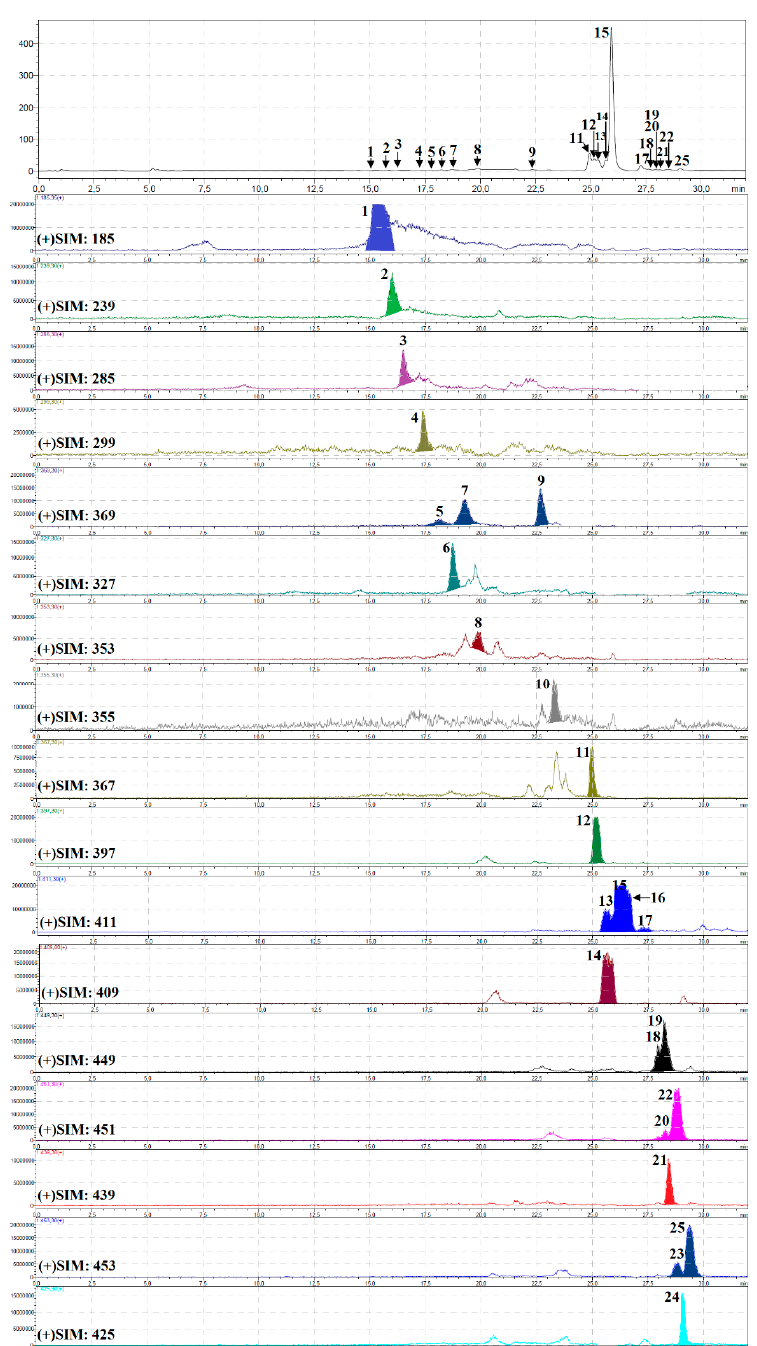
Figure 2. HPLC-DAD chromatogram (330 nm; ( a ) and HPLC-ESI-MS chromatograms (selected ion monitoring mode (SIM), positive ionization; ( b ) of hexane fraction of Phlojodicarpus sibiricus roots. Compounds are numbered as listed in Table 2.